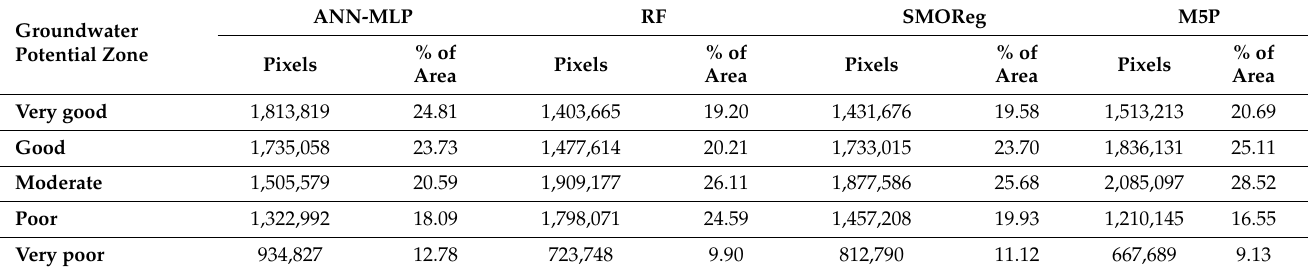
Table 3. Area under different groundwater potential zones derived by different methods.